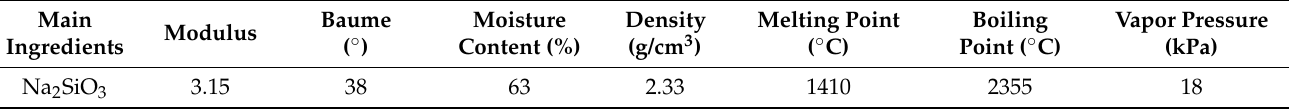
Table 2. Physical performance index of Water Glass.